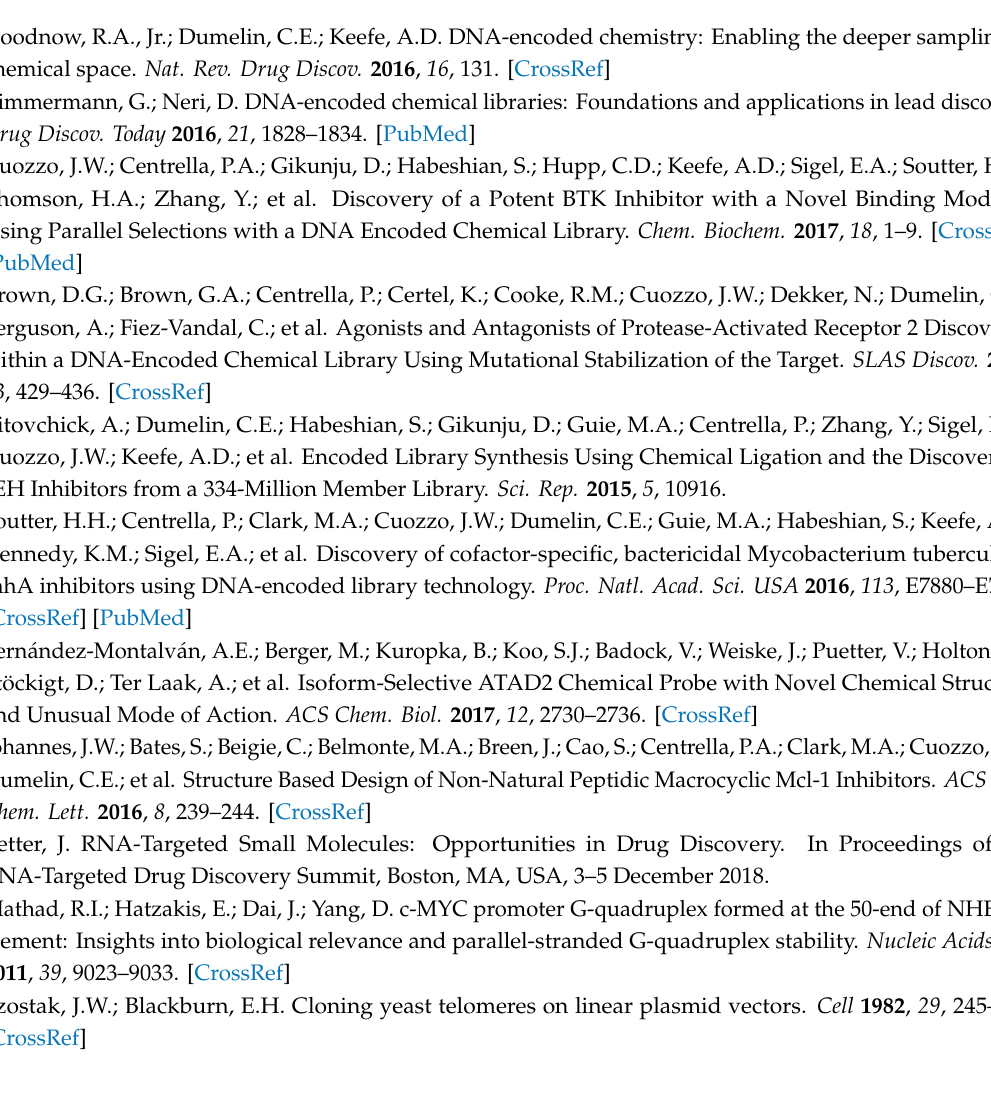
Figure S1: Compound 3 used as a negative control in the PCR-stop assay. Figure S2: LCMS of the DNA oligonucleotides used as targets for the a ffi nity-mediated selection. Figure S3: Scheme of the synthesis of Compound 1 . Figure S4: Scheme of the synthesis of Compound 2 . Figure S5: Full gels of the PCR-stop assay. Figure S6: Full gels of the RT-PCR reactions derived from cells treated with di ff erent concentrations of Compound 2 . Scheme S1: Synthesis of Compound 1 . Scheme S2: Synthesis of Compound 2